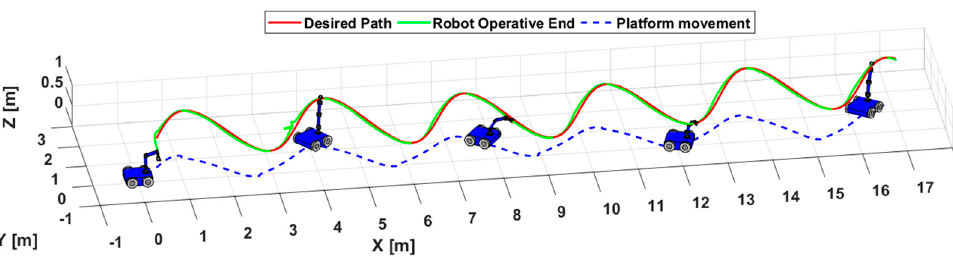
Figure 21. Path selected for the third experiment considering ROC analysis and manipulability.